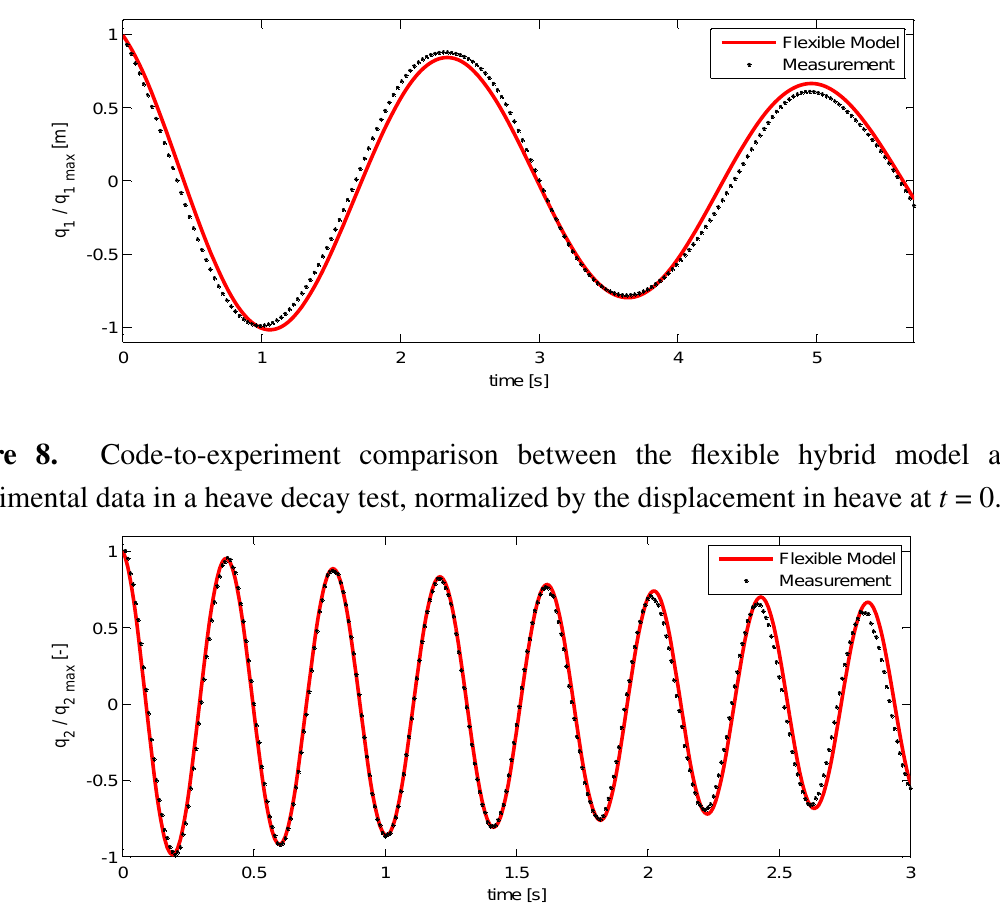
Figure 7. Code-to-experiment comparison between the flexible hybrid model and experimental data in a surge decay test, normalized by the displacement in surge at t = 0.